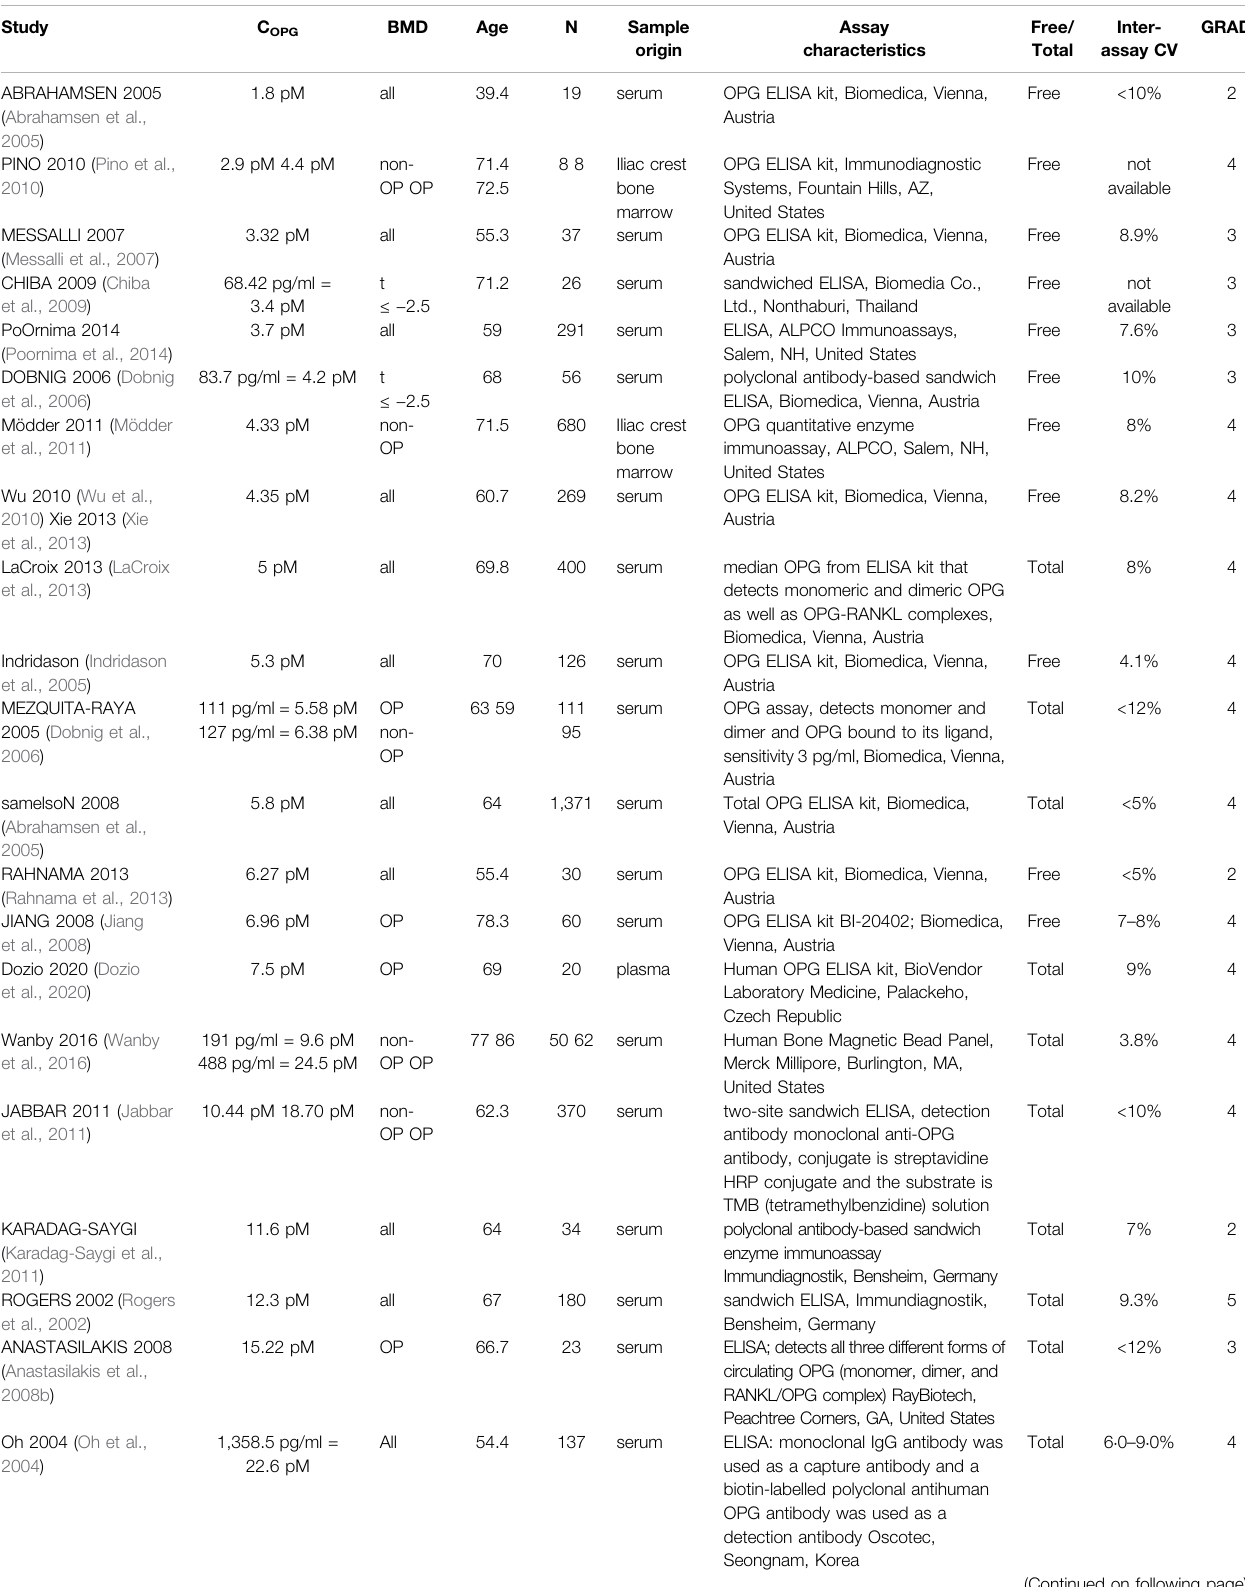
TABLE 5 | Average OPG concentration measurements in postmenopausal women, in ascending order.